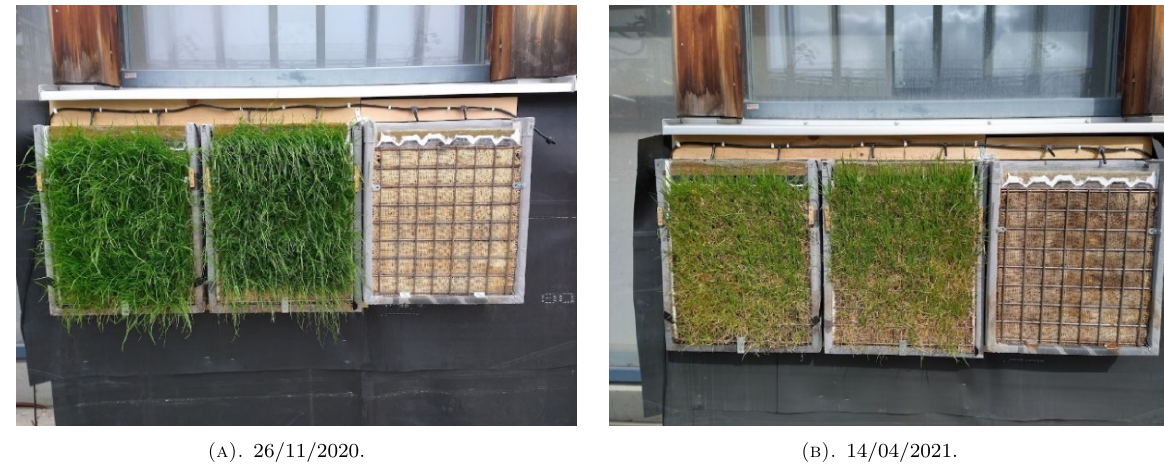
Figure 1. The first prototypes placed on the test